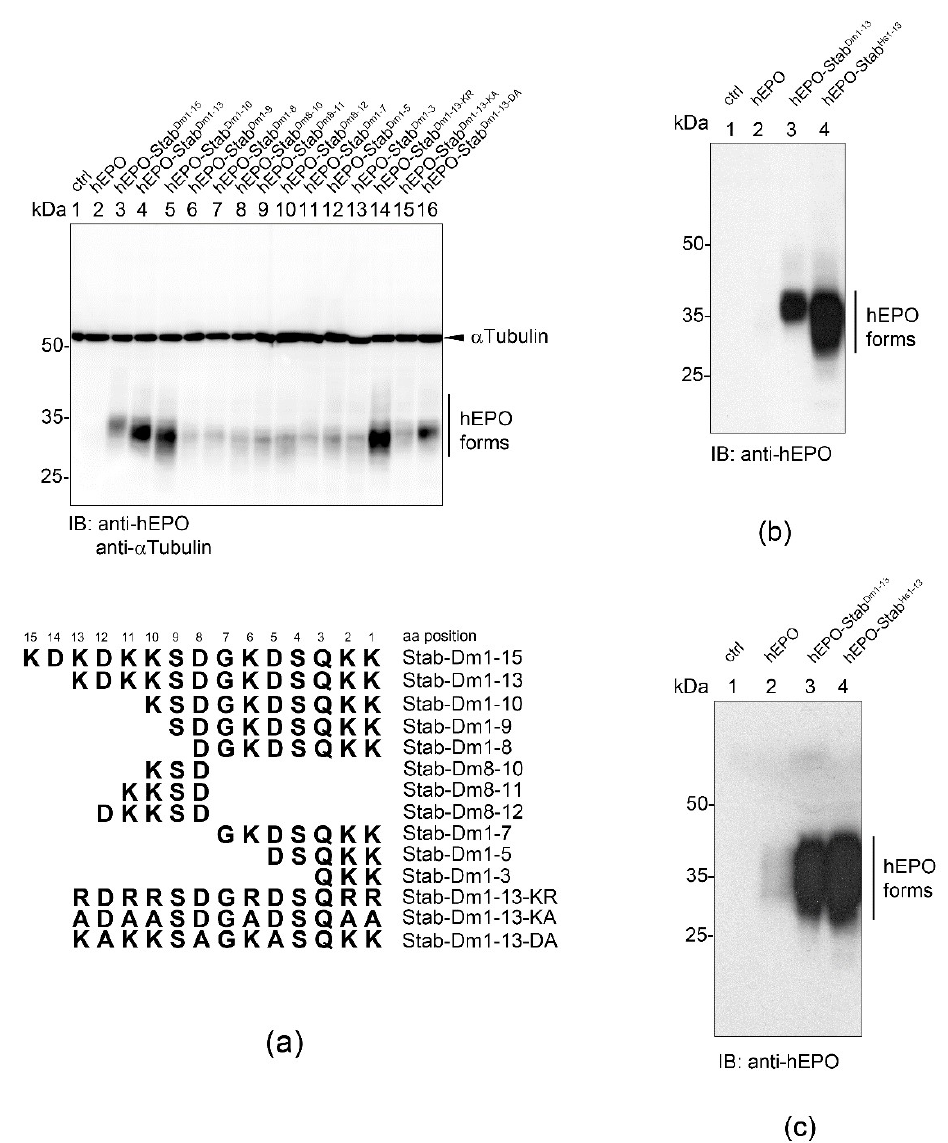
Figure 6. The effect of STABILON derivatives on the accumulation of hEPO in mammalian cells. ( a ) hEPO (lane 2), hEPO-Stab Dm1−15 (lane 3), hEPO-Stab Dm1−13 (lane 4), hEPO-Stab Dm1−10 (lane 5), hEPO-Stab Dm1−9 (lane 6), hEPO-Stab Dm1−8 (lane 7), hEPO-Stab Dm8−10 (lane 8), hEPO-Stab Dm8−11 (lane 9), hEPO-Stab Dm8−12 (lane 10), hEPO-Stab Dm1−7 (lane 11), hEPO-Stab Dm1−5 (lane 12), hEPO-Stab Dm1−3 (lane 13), hEPO-Stab Dm1−13-KR (lane 14), hEPO-Stab Dm1−13-KA (lane 15) and hEPO-Stab Dm1−13-DA (lane 16) transgenes in stably transfected CHO-K1 cells were induced by doxycycline-treatment for 24 h, respectively. The intracellular accumulation of hEPO derivatives was analyzed in total cell extracts by Western blotting using anti-hEPO monoclonal antibody. αTubulin served as loading control. The lower diagram shows the amino acid positions and composition of the STABILON derivatives fused to hEPO. ( b ) hEPO (lane 2), hEPO-Stab Dm1-13 (lane 3) or hEPO-Stab Hs1–13 (lane 4) were expressed in stably transfected CHO-K1 cells by doxycycline-treatment for 24 h. Accumulation of hEPO derivatives was analyzed in total cell extracts by Western blotting using anti-hEPO monoclonal antibody. Protein extracts of CHO-K1 cells serve as control (lane 1). ( c ) Stably transfected CHO-K1 cells carrying the hEPO (lane 2), hEPO-Stab Dm1−13 (lane 3) and hEPO-Stab Hs1−13 (lane 4) genes were induced by doxycycline for 24 h. hEPO derivatives secreted into the tissue culture medium were analyzed by Western blotting with anti-hEPO monoclonal antibody. Tissue culture medium of CHO-K1 cells served as control (lane 1).